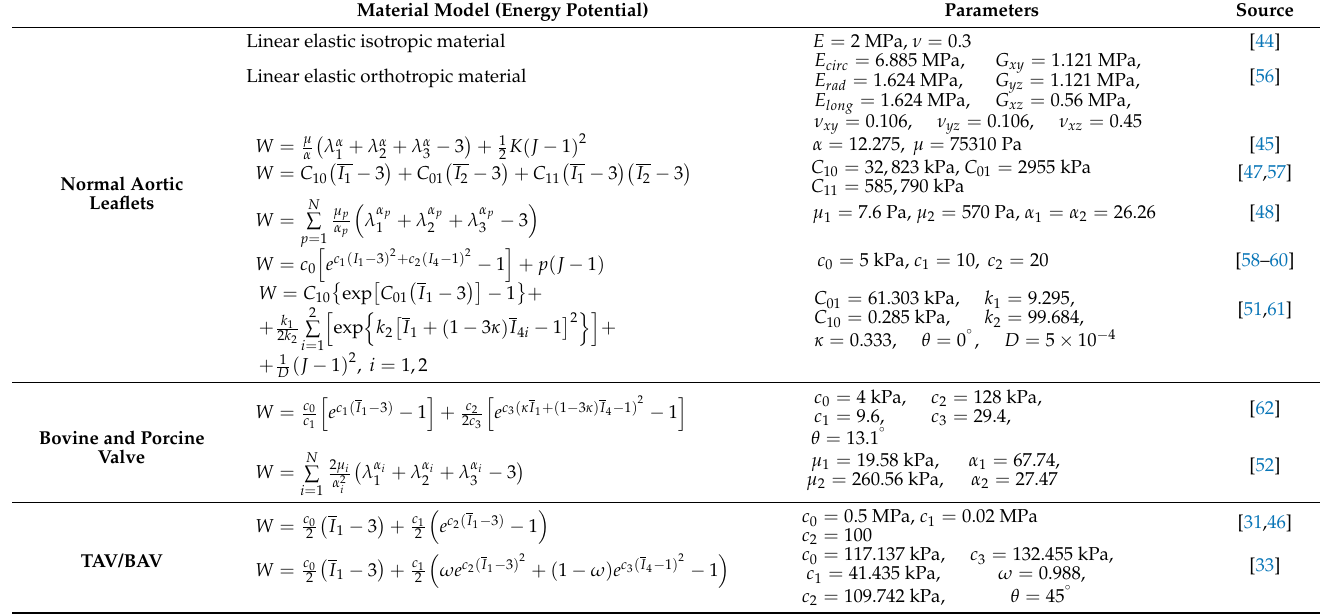
Table 1. Comparison of material models to describe aortic valve